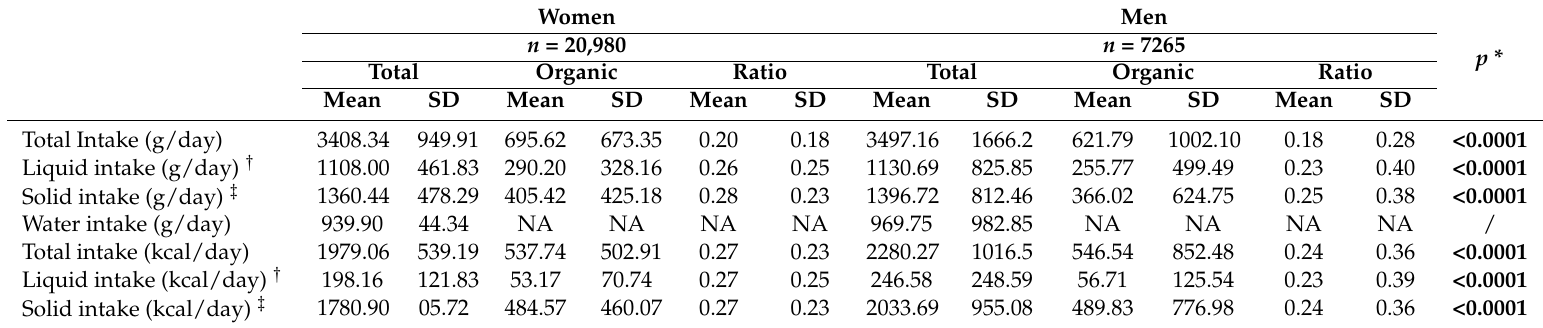
Table 2. Share of organic food in the whole diet by gender (g/day and kcal/day), NutriNet-Santé Study, N = 28,245.